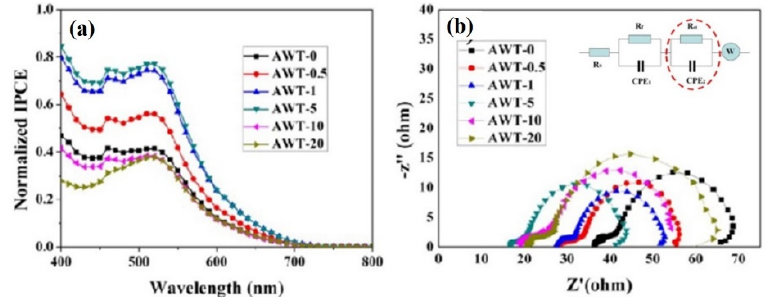
Figure 5. ( a ) Normalized IPCE and ( b ) Nyquist plots for DSSCs: AWT-0, AWT-0.5, AWT-1, AWT-5, AWT-10, and AWT-20 composite films electrodes; the inset image of ( b ) is the equivalent circuit.